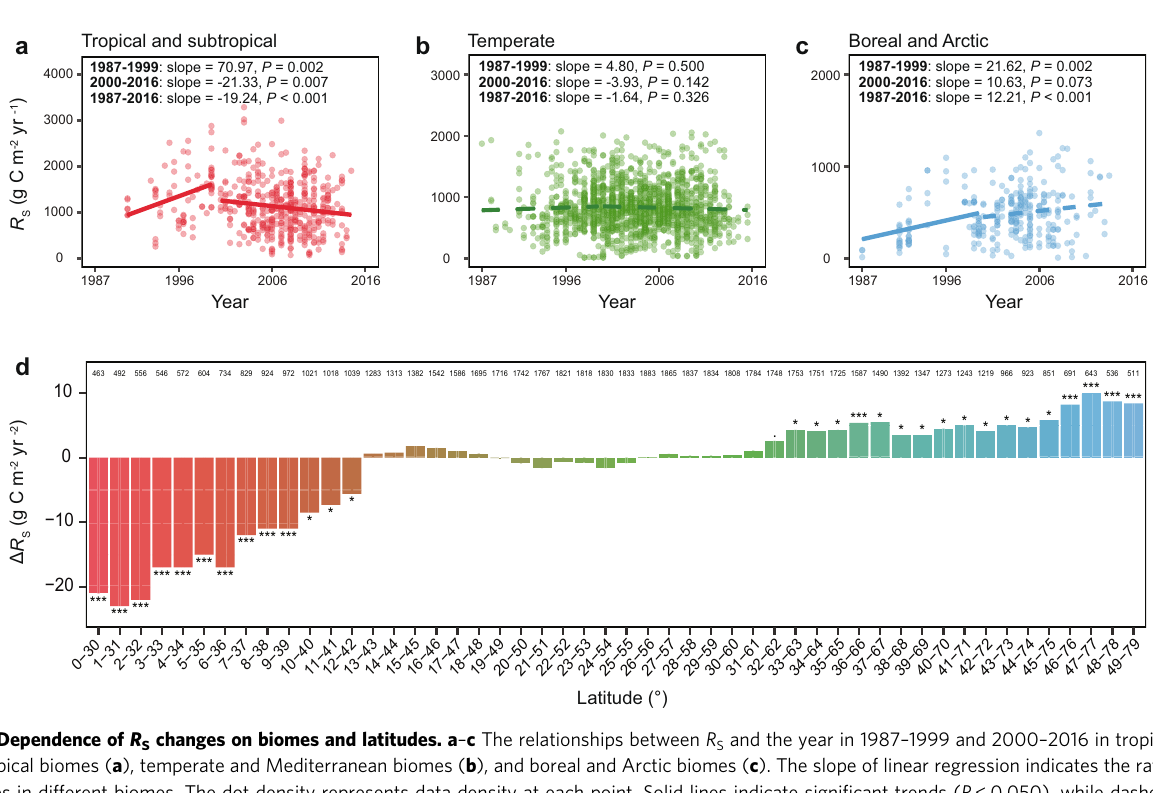
Fig. 2 Dependence of R S changes on biomes and latitudes. a – c The relationships between R S and the year in 1987 – 1999 and 2000 – 2016 in tropical and subtropical biomes ( a ), temperate and Mediterranean biomes ( b ), and boreal and Arctic biomes ( c ). The slope of linear regression indicates the rate of R S changes in different biomes. The dot density represents data density at each point. Solid lines indicate signi fi cant trends ( P < 0.050), while dashed lines indicate insigni fi cant trends ( P ≥ 0.050). d Latitude dependence of R S changes based on the moving subset window analysis. Each window includes a subset of R S data within a 30° latitude interval and moves forward by 1° step. The bars represent the rates of R S changes in different latitudes, calculated as average annual R s change ( Δ R s) in 1987 – 2016. The number above each bar refers to the number of R S records belonging to the subset window. The color scale of the bars corresponds to the colors representing different biomes in ( a – c ). *** P < 0.001, ** P < 0.010, * P <